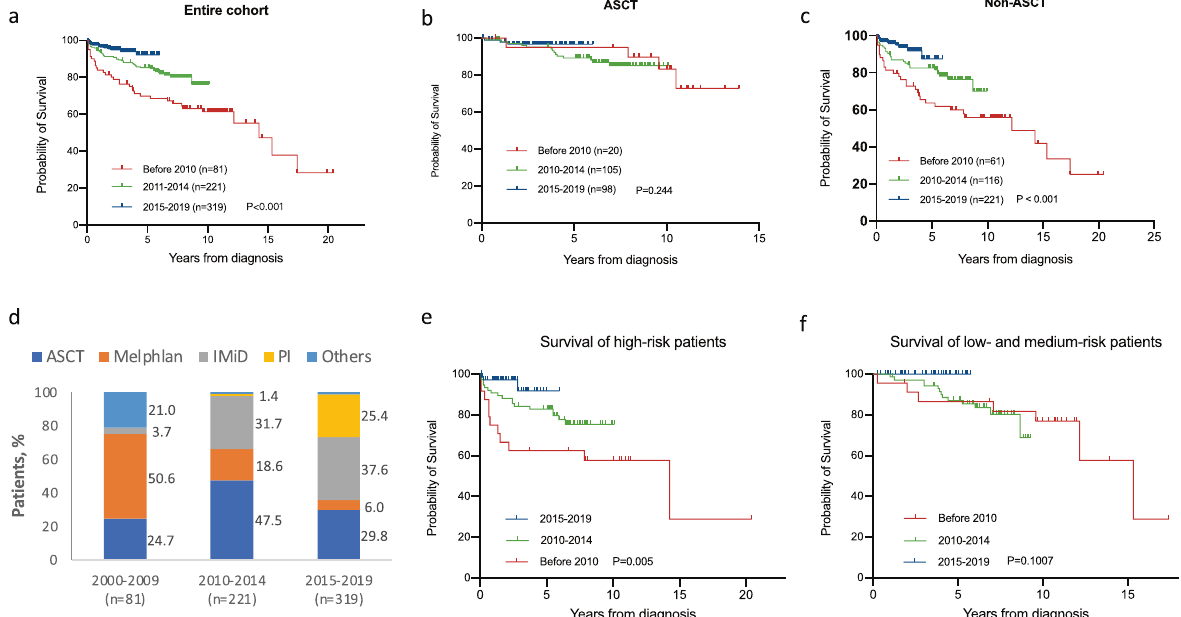
Fig. 1 Changes in the treatment and outcomes in the past three periods. a . Kaplan – Meier curve for overall survival of entire cohort. b Kaplan – Meier curve for overall survival of patients who underwent ASCT by time period. c Kaplan – Meier curve for overall survival of